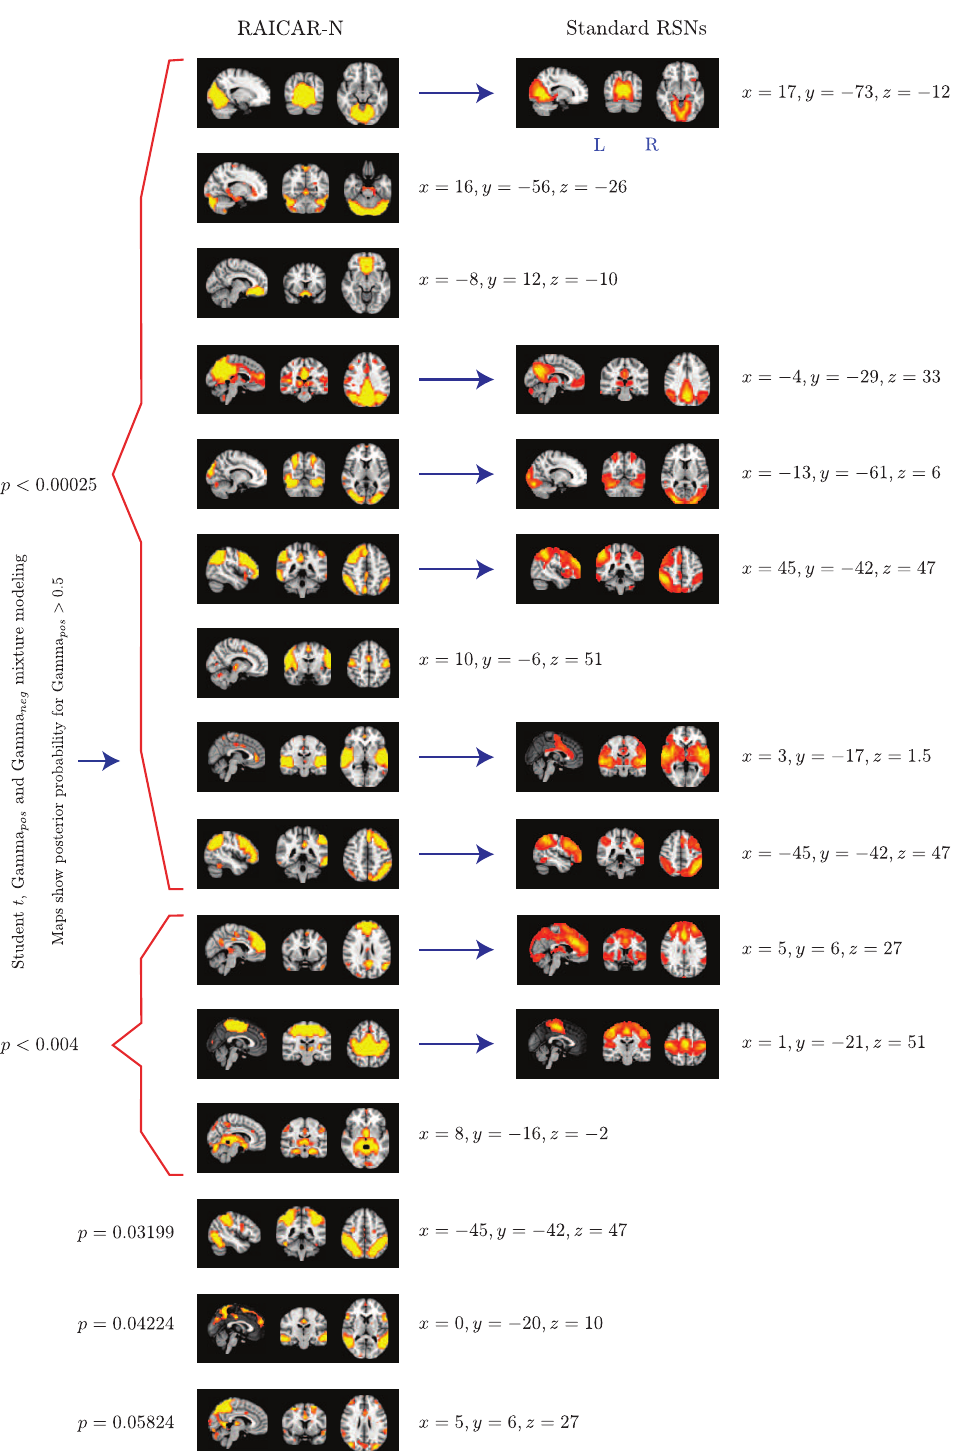
Figure 13. The top 15 ‘‘reproducible’’ ICs from K ~ 100 runs of L ~ 5 subject group ICA RAICAR-N analysis compared with standard RSN maps reported in literature [ 8 ] . We are able to declare 8 ‘‘standard’’ RSNs as significantly reproducible at a p -value of v 0 : 05 . There are 6 other ‘‘non-standard’’ RSNs that can be declared as significantly reproducible at a p -value of v 0 : 05 and 1 other ‘‘non-standard’’ RSN that achieves a p - value of 0 : 05824 .